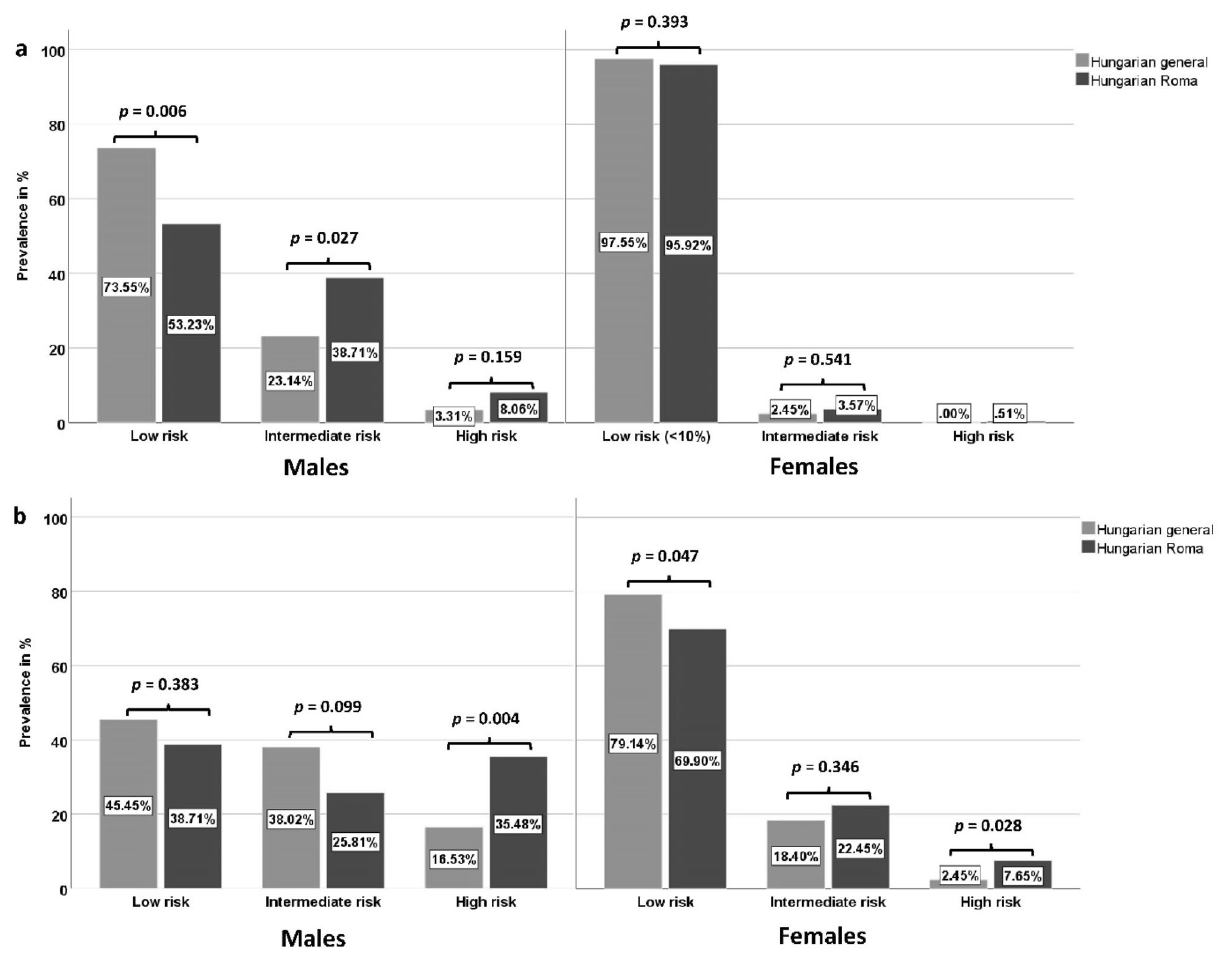
Figure 2. Distribution of subjects by risk categories defined by Framingham Risk Score for hard coronary heart disease (FRSCHD-a) and Framingham Risk Score for cardiovascular disease (FRSCVD-b) calculations in the 30–64-year-old Hungarian general and Hungarian Roma populations.